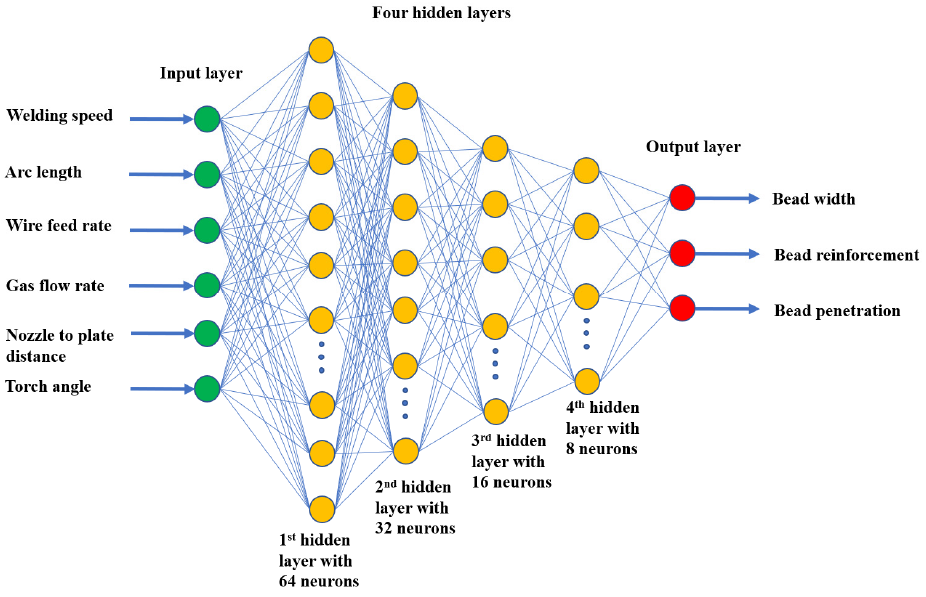
Figure 8. Deep learning neural network architecture for the MIG welding process. Table 8. Network architecture of MIG welding process. Table 9. Parameters for training network and root mean squared error (RMSE).